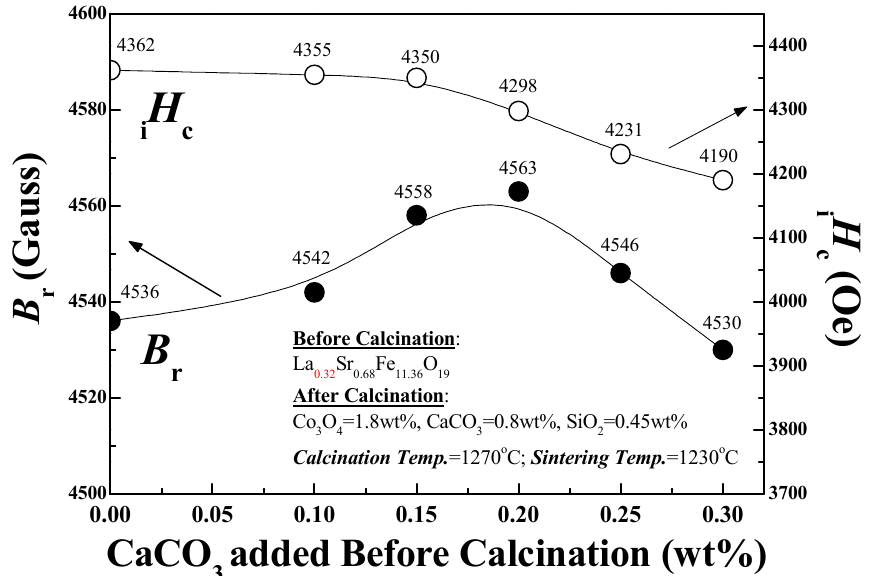
Figure 7. Dependence of B r and i H c of the sintered magnet on the amount of CaCO 3 added in the La 0.32 Sr 0.68 Fe 11.36 O 19 calcined ferrite.